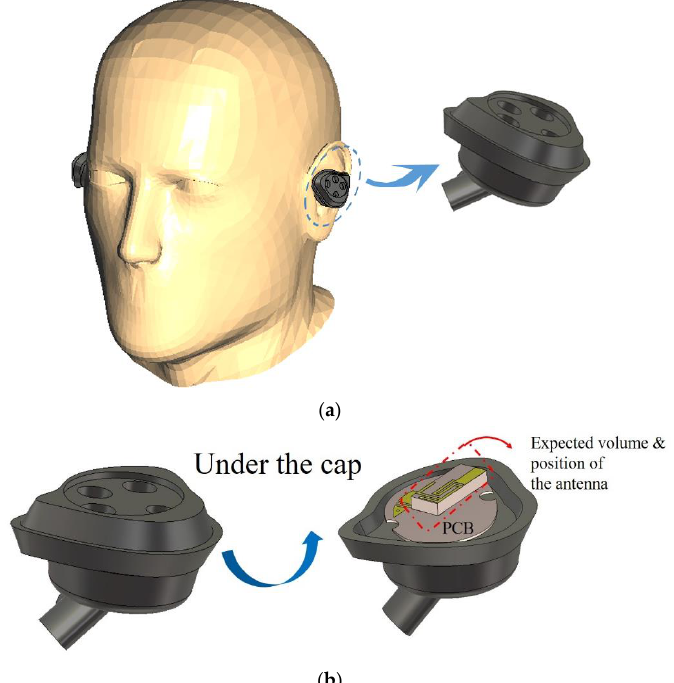
Figure 1. The earphone placed in the ear of the SAM. ( a ) Overall view; ( b ) antenna in the earphone.